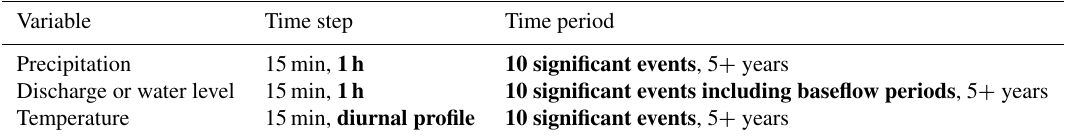
Table 2. Typical data requirements for the DBM methodology to be applied in a catchment (minimal data requirements in bold) (after Smith et al., 2013). Temperature only required if snow melt is a significant runoff generation mechanism (Smith et al., 2014). Variable